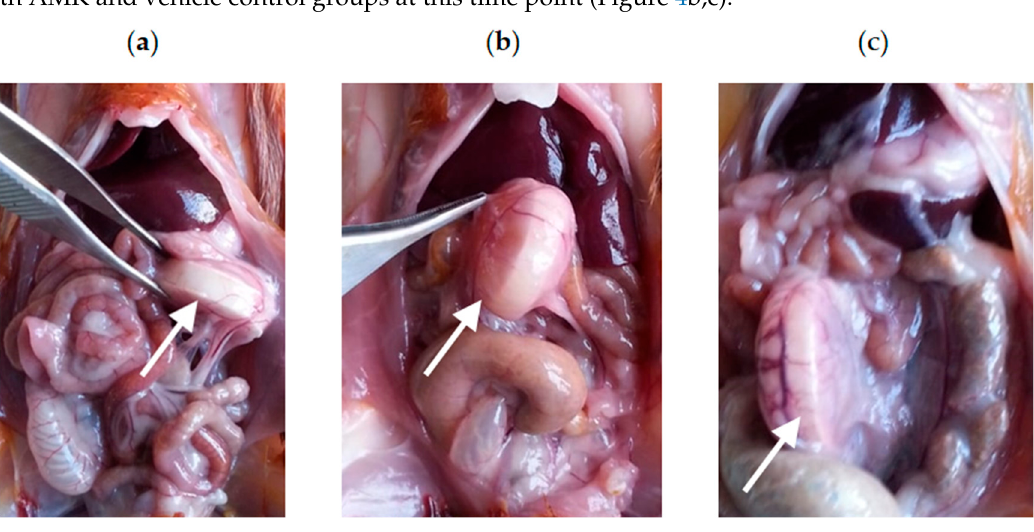
Figure 4. Intraoperative view of the diffusion chambers in the abdominal cavity on the 8 th day of administration of: ( a ) LysECD7 (100 µg/mL), ( b ) amikacin (5 mg/mL), ( c ) vehicle control.